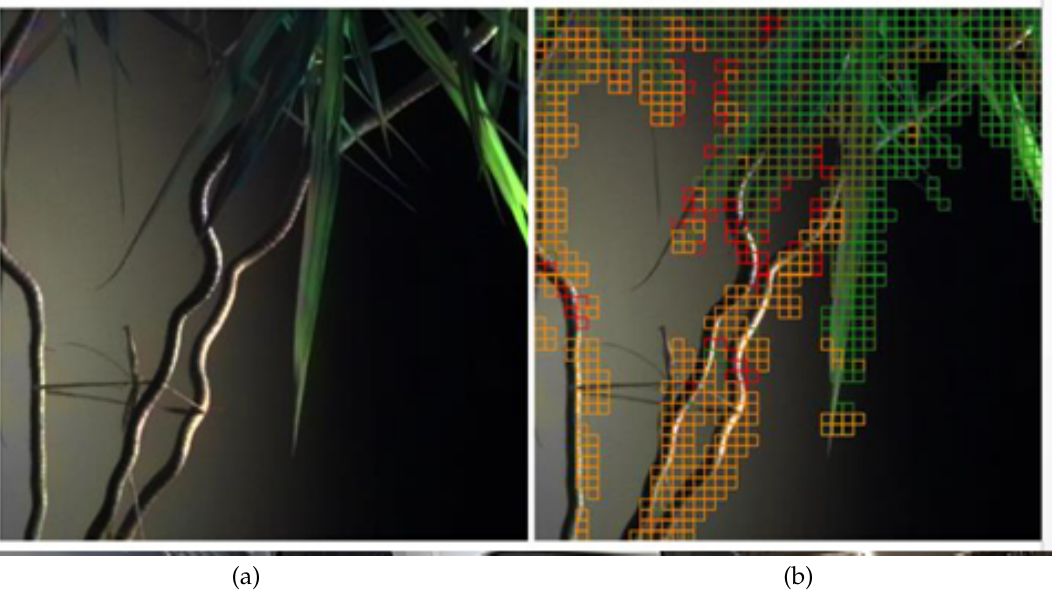
Figure 5. The image taken by a Cubert Q285 camera ( a ), and the result of segmentation ( b ). Data for traversability estimation were collected as the robot traveled in different light and weather conditions. The vehicle moved on asphalt, a bumpy road, a forest road, and grass. Figure 6 shows images of each type of road. The photos are divided into the square cells shown in Figure 6 (red grid). A spectral distribution is created for each cell, and a label (class) is assigned.